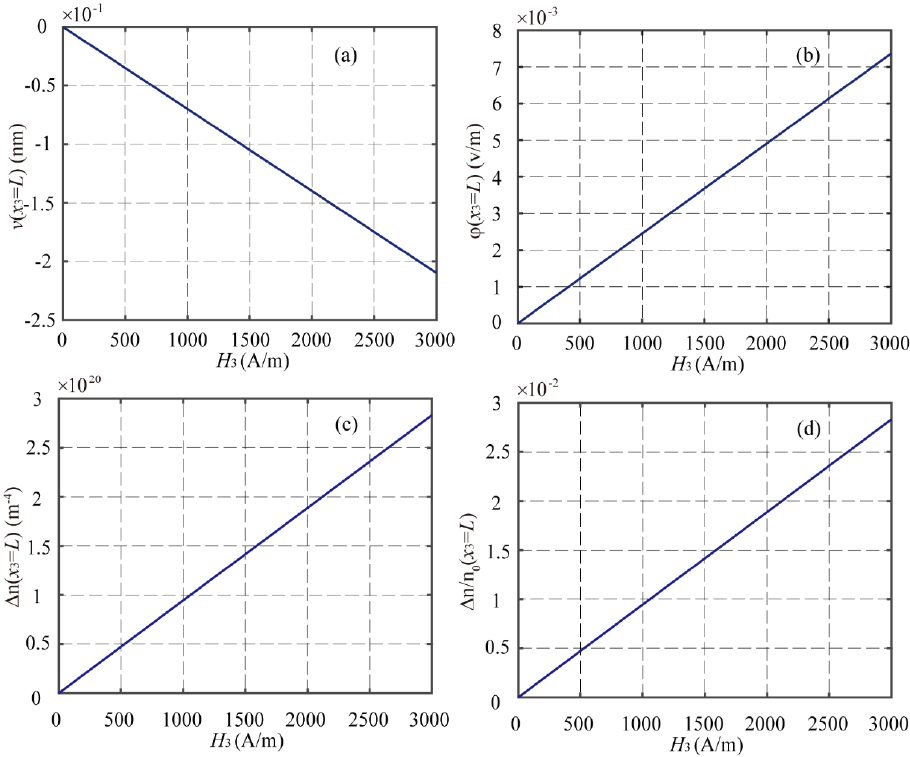
Δ Δ , and ( d ) 0 / n n at x 3 = L of the LMPS beam with n 0 =